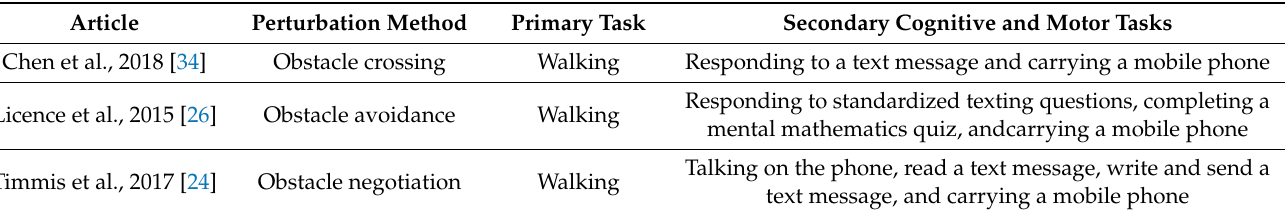
Table 3. Secondary cognitive and motor task combinations during trip recovery and obstacle